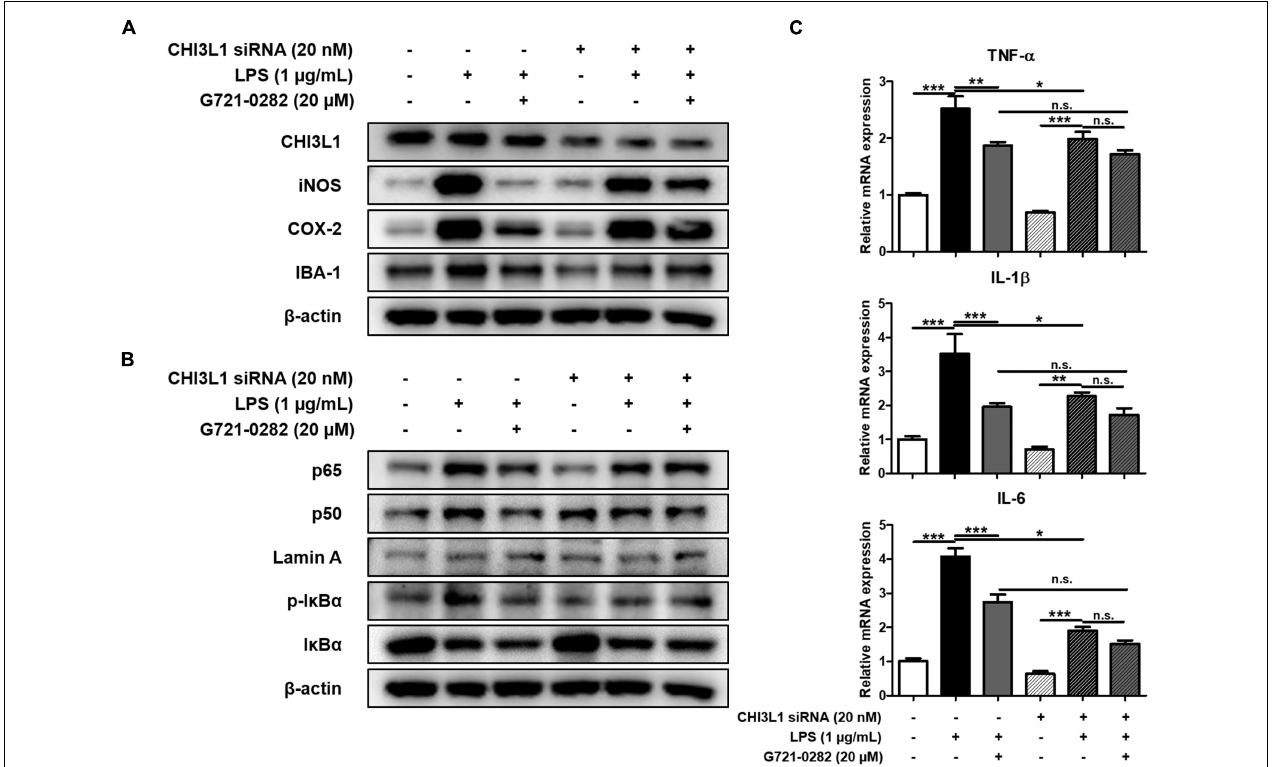
FIGURE 4 | Offset of effects of G721-0282 on neuroinflammation by CHI3L1 siRNA in BV-2 cells. The expression of iNOS, COX-2, and IBA-1 were detected by Western blot in BV-2 cells treated with siCHI3L1 and G721-0282 (A) . Phosphorylation of I κ B, and p50 and p65 (Nuclear) translocation were detected by Western blot in BV-2 cells treated with siCHI3L1 and G721-0282 (B) . The loading control, β -actin, was reused in (A,B) , because (A,B) were obtained from the same amount of the same samples. The mRNA expression level of pro-inflammatory cytokines (TNF- α , IL-1 β , and IL-6) in BV-2 cells treated with siCHI3L1 and G721-0282 were assessed by qRT-PCR (C) . ∗ , Significantly different between two groups ( p < 0.05). ∗∗ , Significantly different between two groups ( p < 0.01). ∗∗∗ , Significantly different between two groups ( p < 0.001).